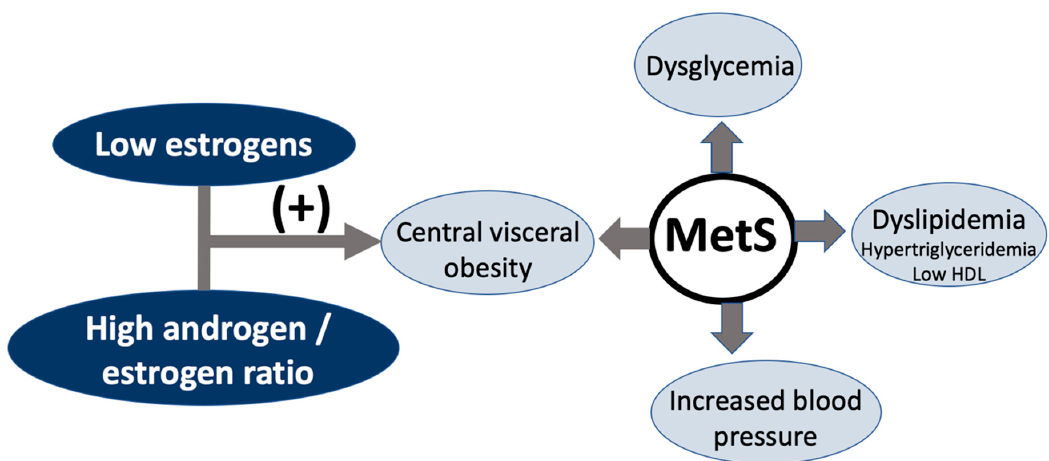
Figure 2. The metabolic syndrome (MetS) is defined as a cluster of four different risk factors, namely, dysglycemia, dyslipidemia, increased blood pressure, and central visceral obesity. While these